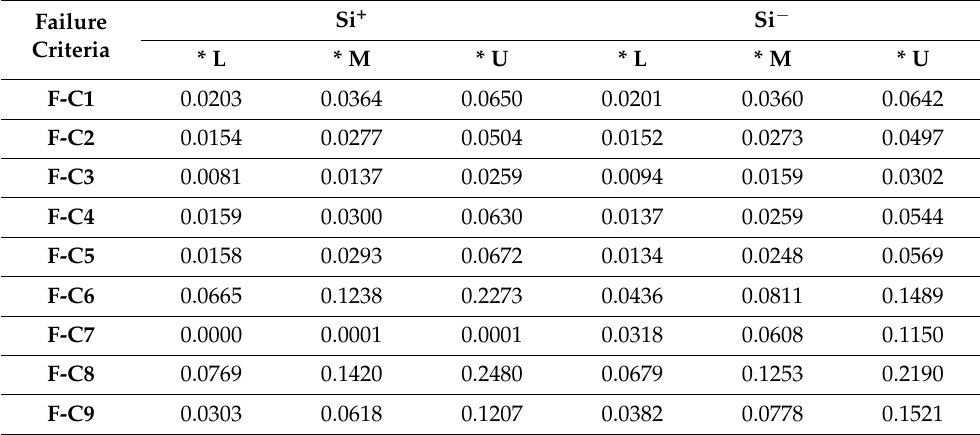
Table 13. FPIS and FNIS values at 70% of cyclic loading conditions.